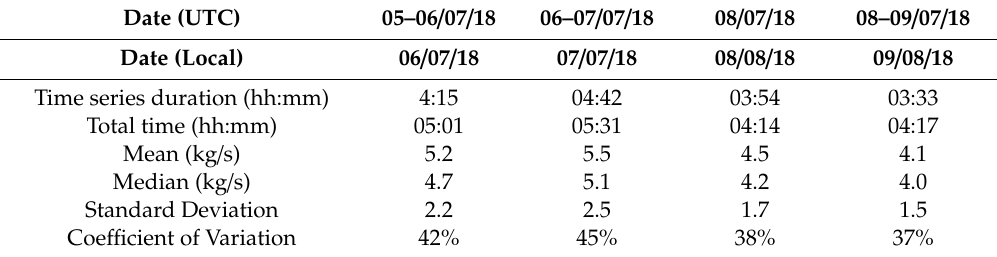
Table 2. A summary of measurement durations and SO 2 flux statistics for daily UV camera measurements at Yasur Volcano in July 2018. UTC is Coordinated Universal